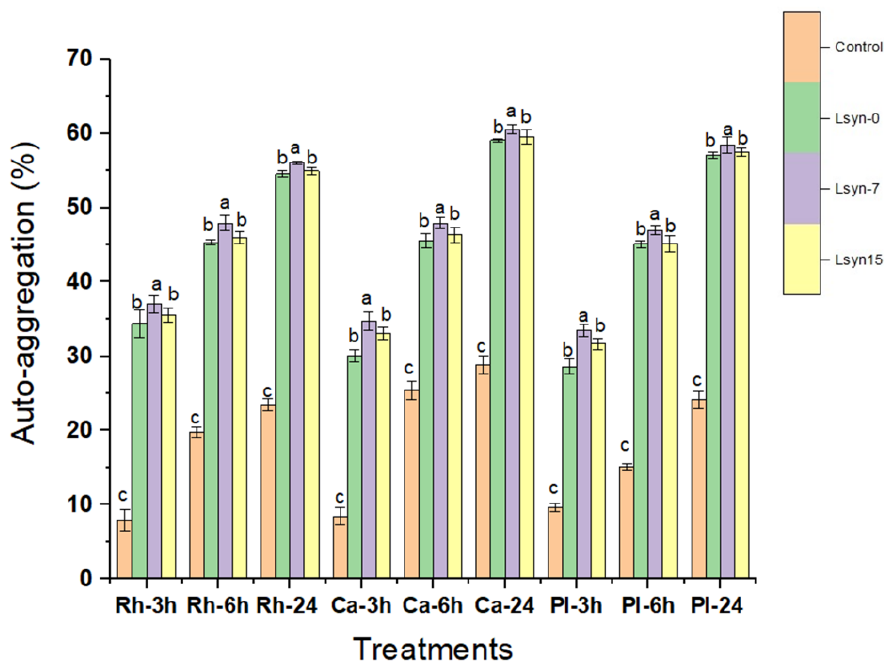
Figure 2. The effect of postbiotics (L syn − 0 , L syn − 7 and L syn − 15 ) on auto-aggregative properties of L. rhamnosus (Rh), L. casei (Ca) and L. plantarum (Pl) after incubated at 37 ◦ C for 3 h, 6 h, and 24 h. Different letters show significant differences at p < 0.05. Error bars indicate the standard division of the sample’s mean.